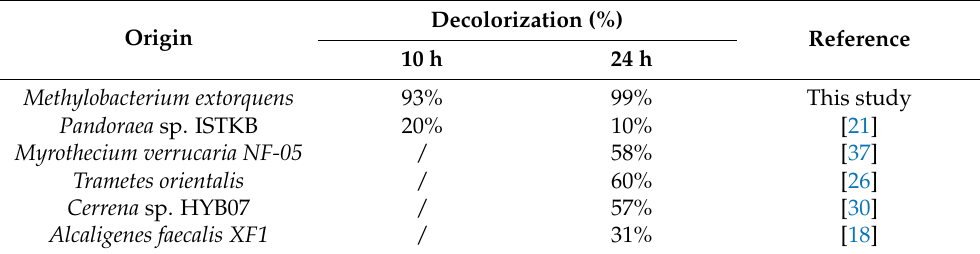
Table 4. Degradation of Congo Red using different sources of